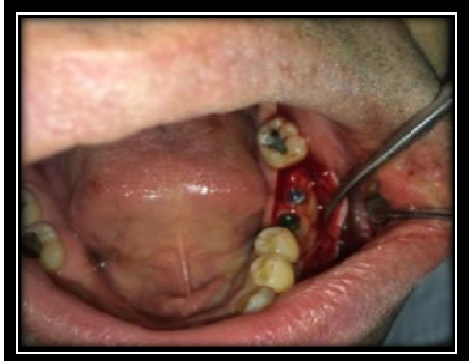
Fig. 4: Placement of the cover screws on 4: Placement of the cover screws on dental For flapless (study) group same surgical